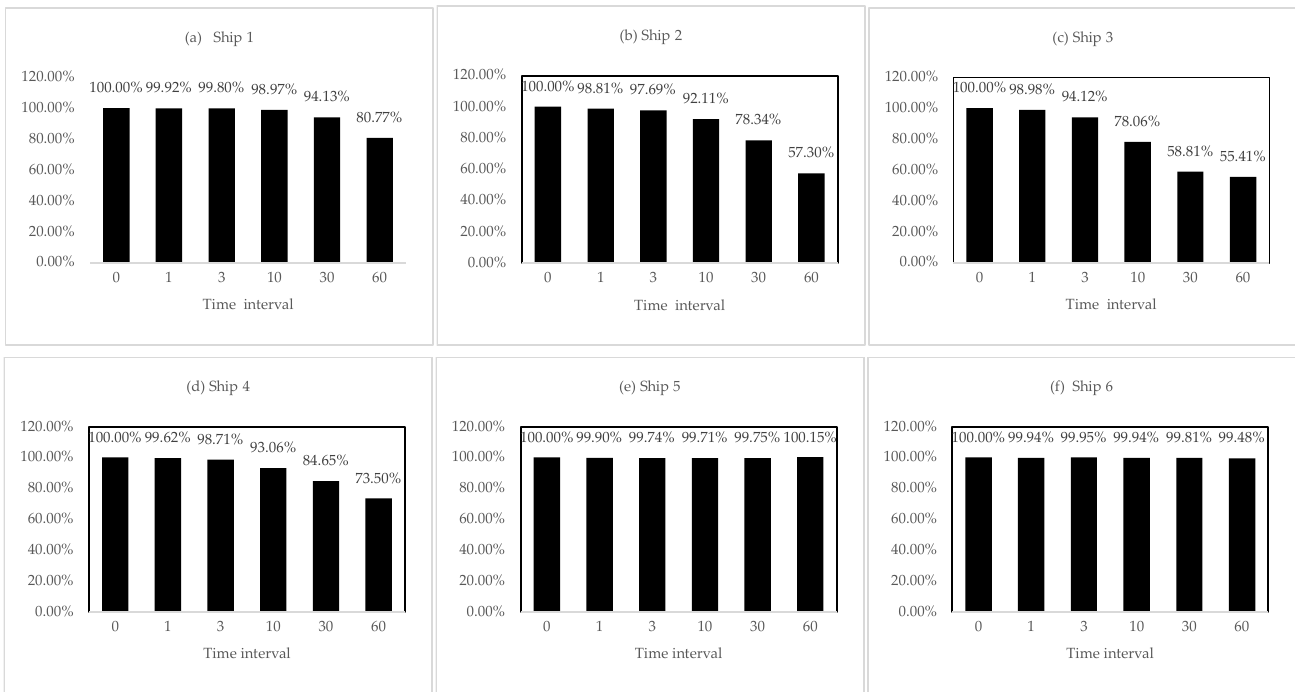
Figure 4. Emissions of CO 2 for the six ships in one day without thinning (0 min) and with thinning at time intervals of 1, 3, 10, 30, and 60 min. ( a ) Ship 1 ( b ) Ship 2 ( c ) Ship 3 ( d ) Ship 4 ( e ) Ship 5 ( f ) Ship 6.